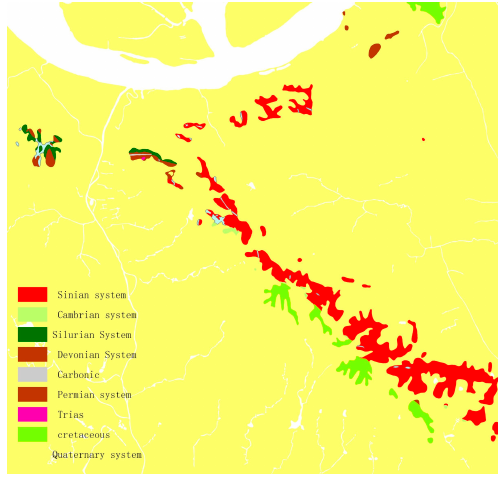
Figure 13. Modelling of strata objects.